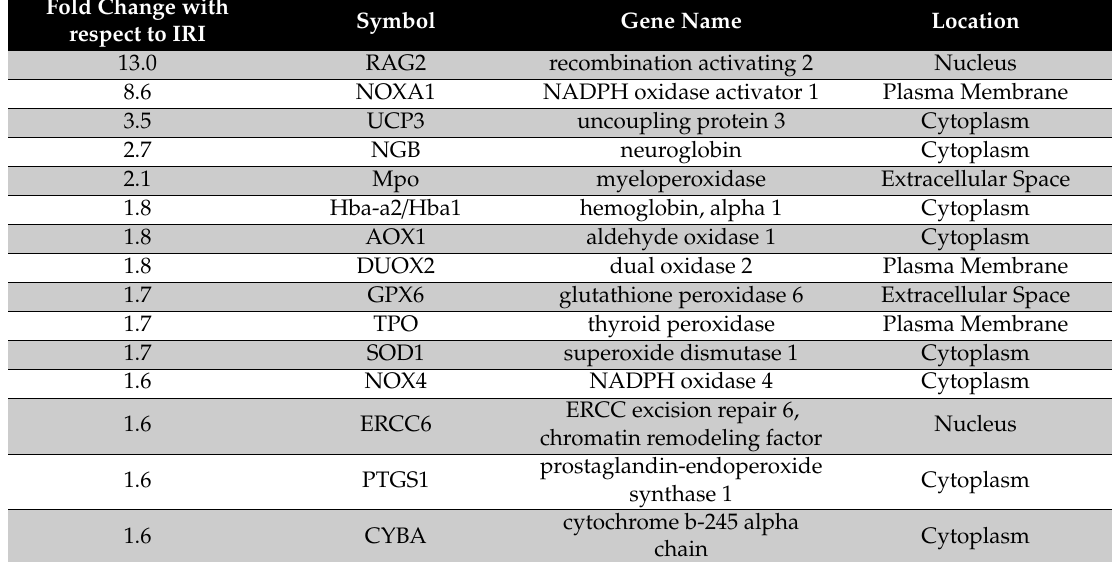
Table 1. Genes modulated by iPSC-EV treatment during IRI and associated with oxidative stress in renal tissue (iPSC-EV with respect to